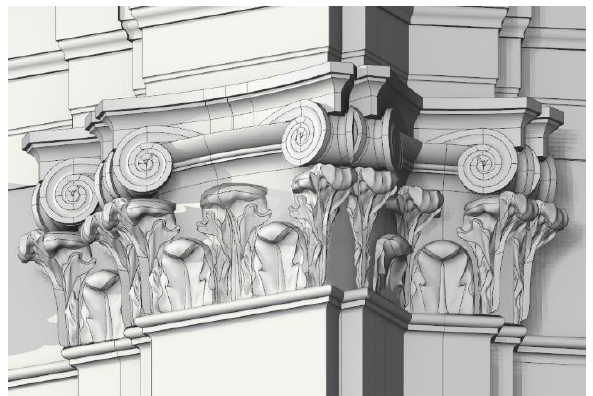
Figure 6. Polygonal model (left) and orthophoto (right) of the composite capital obtained with Structure from Motion process with Agisoft software